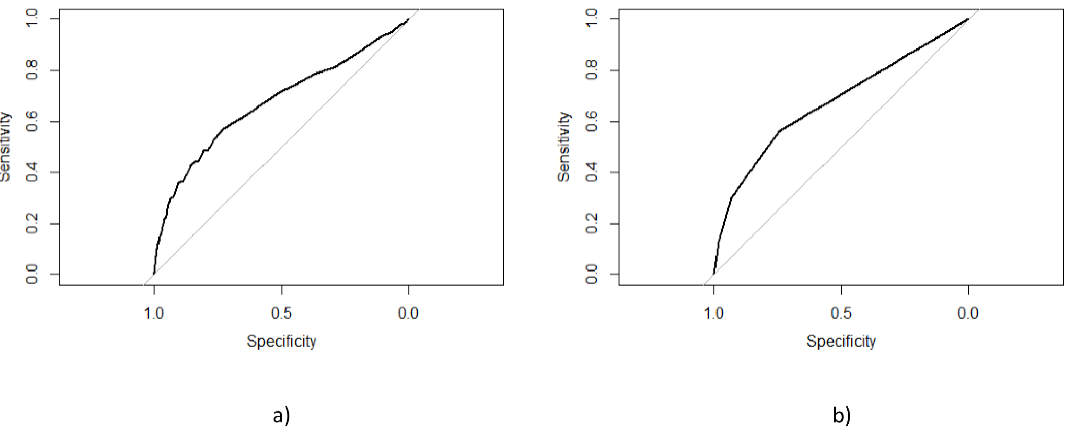
Figure 4. ( a ) ROC curve model for evidence consisting of the values of all variables except Dead ; ( b ) ROC curve model for evidence consisting of the values of variables Walk_out and Health .